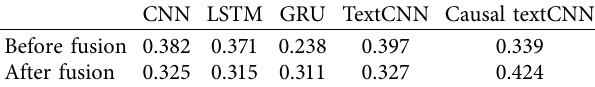
Table 3: Score of model before and after feature fusion.